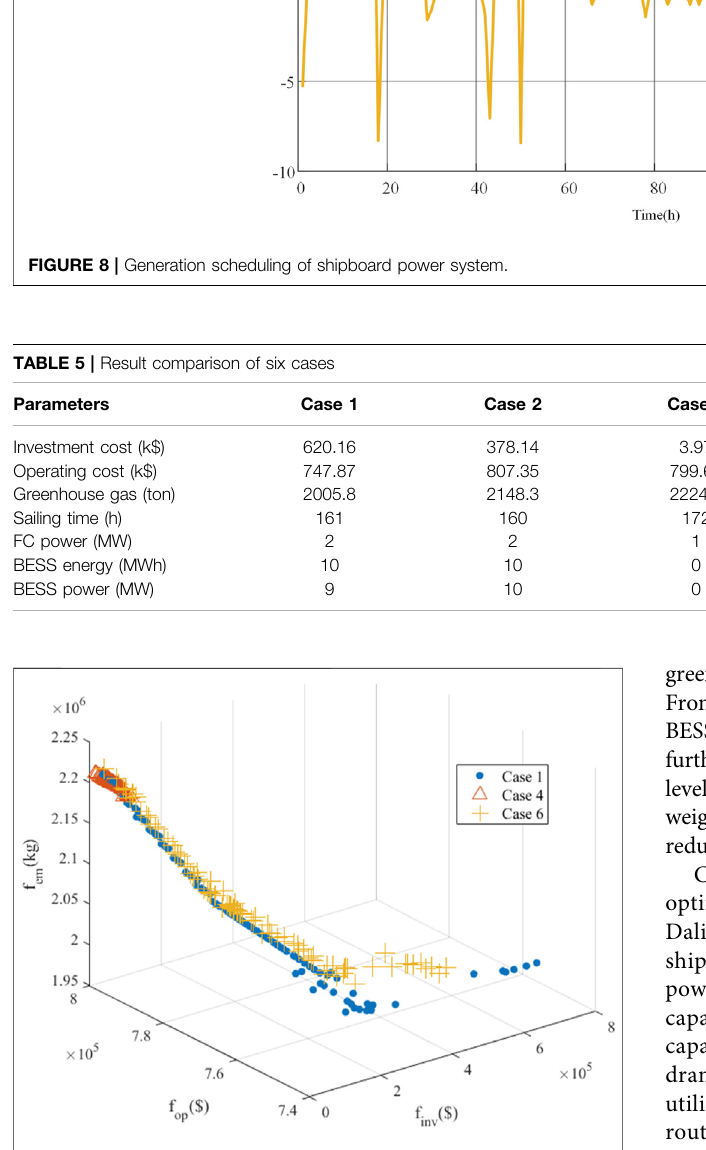
FIGURE 9 | Comparison of Pareto fronts in Cases 1, 4, and